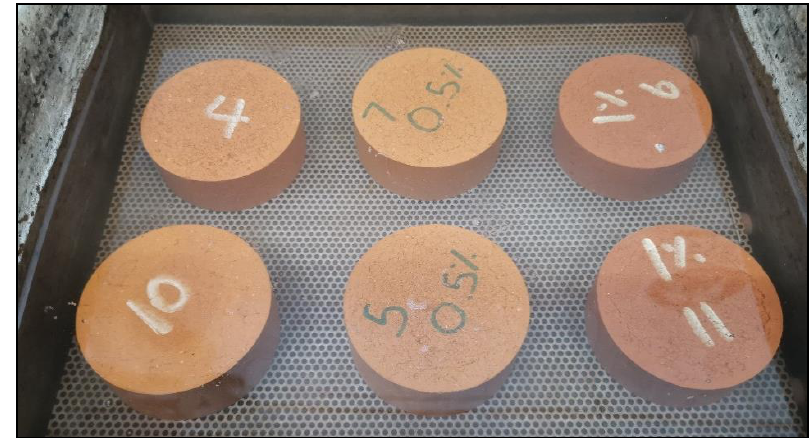
Figure 13. 24-hour cold water and 5-hour boiling water test.